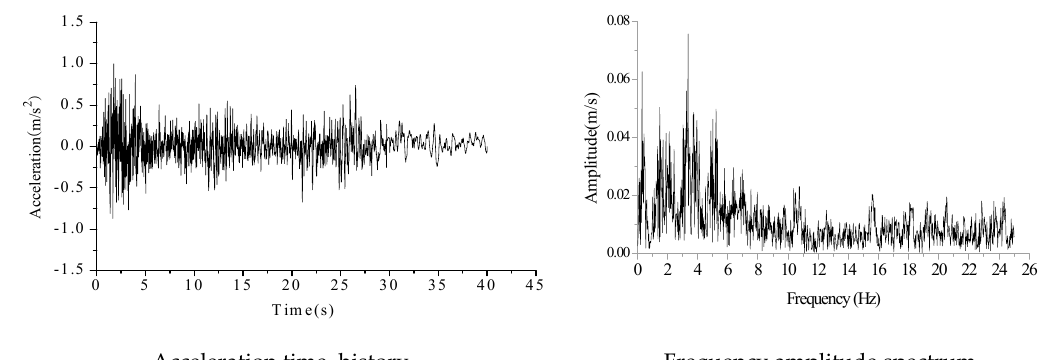
Figure 9. El-Centro motion in the horizontal direction after inversion.